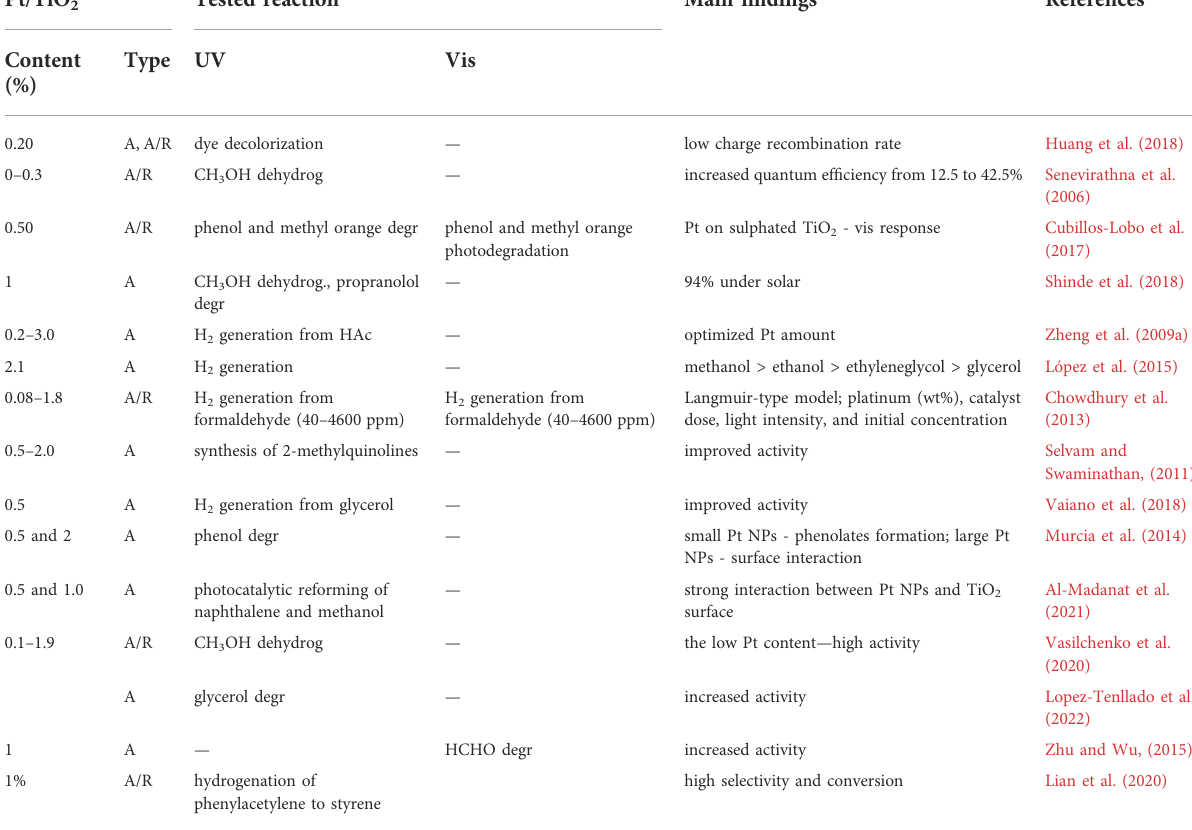
TABLE 2 The examples of enhanced photocatalytic activity after platinum deposition on titania. Pt/TiO